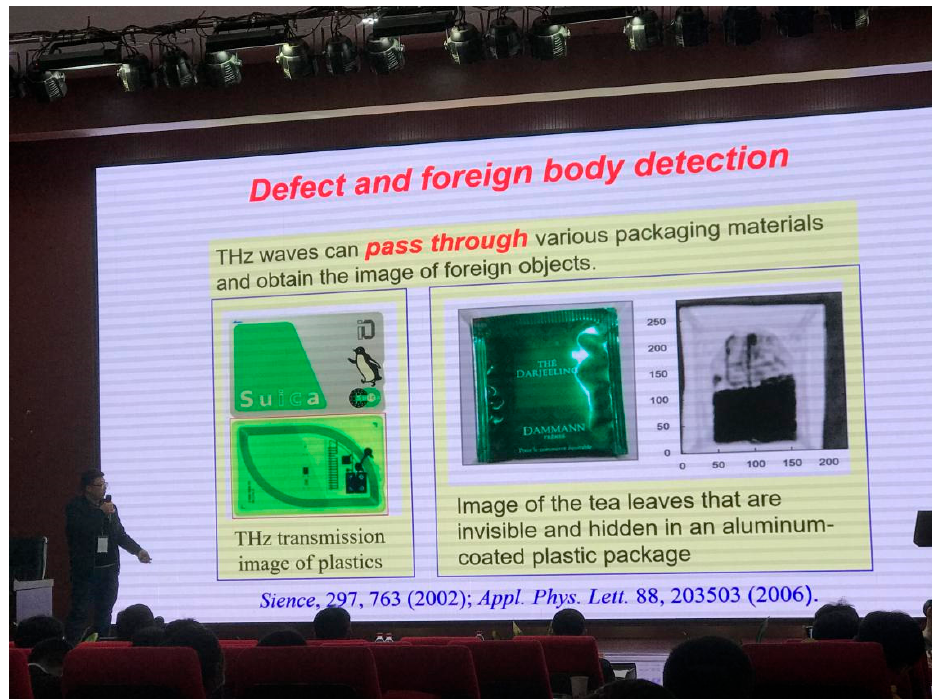
Figure 9. The speech of Associate Professor Sun Xu-dong: The Application of the THz